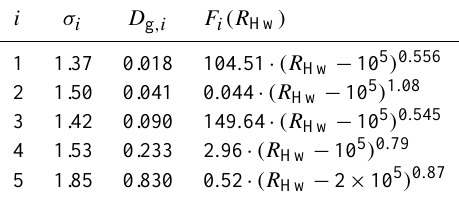
Table 1. Log-normal parameters for the Ovadnevaite et al. (2014) sea spray source function. The geometric standard deviation for each mode is denoted by σ i , the geometric mean (count-median) diameter by D g ,i , and the mode total number flux by F i (R Hw ) . The number flux is expressed as a function of Reynolds number ( R Hw ).